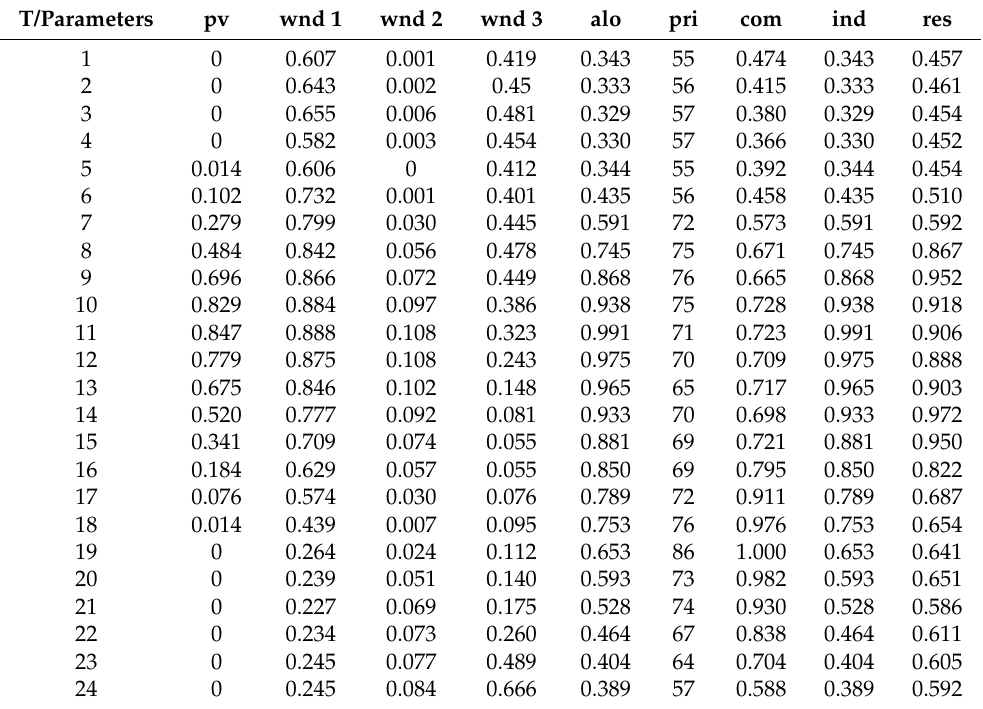
Table A3. Table representing the parameters regarding sources, price of energy market and demand profile in